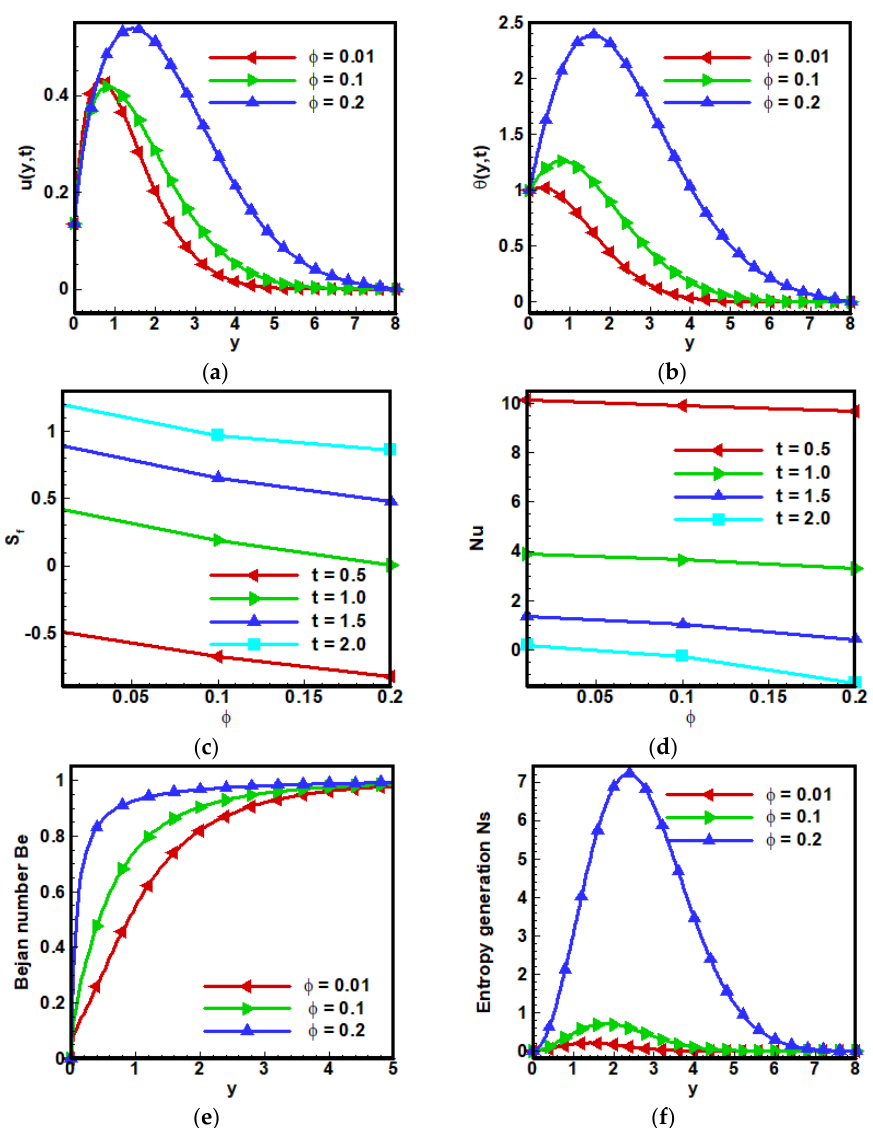
Figure 5. Effect of 𝜙 on ( a ) dimensionless velocity profile, ( b ) non-dimensional temperature profile, Figure 5. Effect of φ on ( a ) dimensionless velocity profile, ( b ) non-dimensional temperature profile, ( c ) coefficient of skin friction, ( d ) local Nusselt number 𝑁𝑢 , ( e ) Bejan number and ( f ) entropy gen- ( c ) coefficient of skin friction, ( d ) local Nusselt number Nu , ( e ) Bejan number and ( f ) entropy genera- eration when Λ (cid:2869) = 0.6,Λ (cid:2870) = 0.5,𝐺𝑟 = 5,𝐻𝑎 = 10,Pr =6,𝑄 (cid:2868) = 5,𝑁𝑟 = 3.5,𝑎 = −1,𝐵𝑟 = 0.5,Ω = tion when Λ 1 = 0.6, Λ 2 = 0.5, Gr = 5, Ha = 10,Pr = 6, Q 0 = 5, Nr = 3.5, a = − 1, Br = 0.5, Ω = 10, 10,𝜙 = 0.1 . φ =